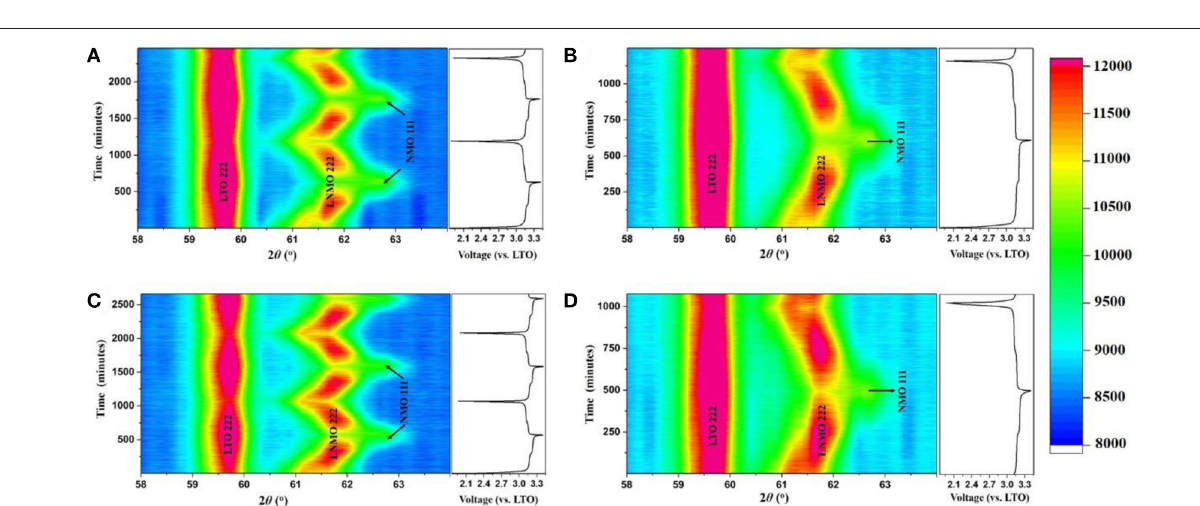
FIGURE 4 | Contour plot of in-operando NPD data of the LNMO||LTO battery (A) for the first two cycles and (B) for the 51st cycle, and of the LNMO||AlF 3 -coated LTO battery (C) for the first two cycles and (D) for the 51st cycle, with intensity (arb.) shown in color with the scale and corresponding voltage curve on the right. LTO 222 and LNMO 222 as well as NMO 111 reflections are